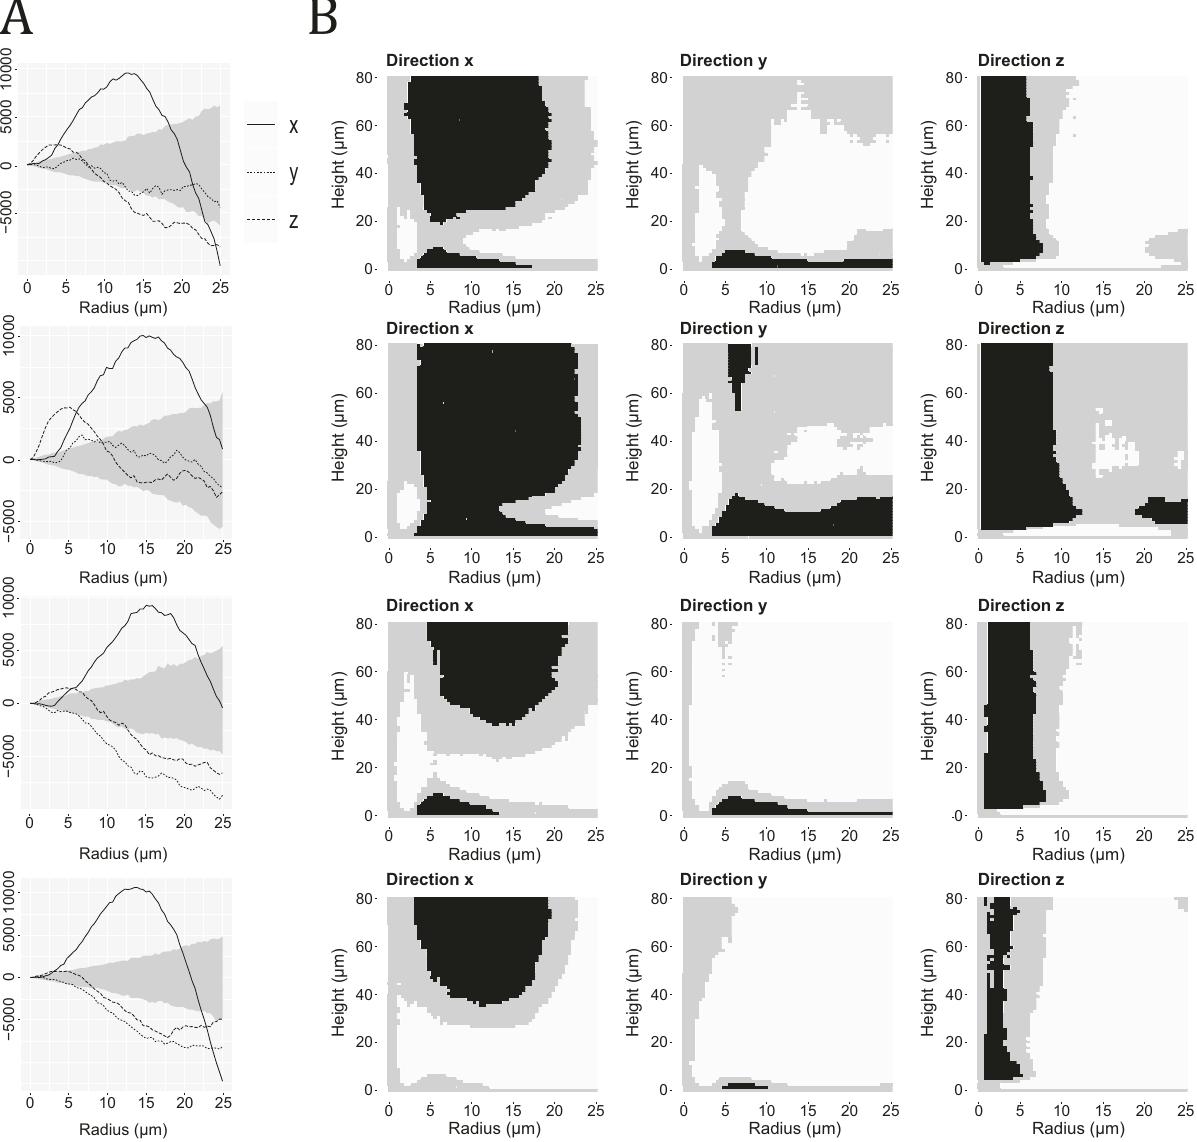
Fig. 6 Results of analyses with the cylindrical K -function for the spatial point patterns of centroids of pyramidal cells. Each row represents a dataset which from top to bottom are Subject 1_1, 1_2, 2, and 3. A 95% global envelopes (shaded area) for the cylindrical K -function, with t = 80 fi xed, and using 2000 CSR simulations. The theoretical value of the cylindrical K -function under CSR was subtracted from the curves for better visualization. The three curves correspond to the empirical cylindrical K -function for each dataset, in the direction of the x -axis (solid lines), y -axis (dotted lines), or z -axis (dashed lines). B Summary of 95% global envelopes for the four datasets based on the cylindrical K -function when varying both the height t and radius r . The envelopes are each based on 4000 CSR simulations. The direction of the cylinders is stated at the bottom of each plot. The plots indicate whether the empirical cylindrical K -function for the observed point pattern is above the envelope (black), within the envelope (gray), or below the envelope